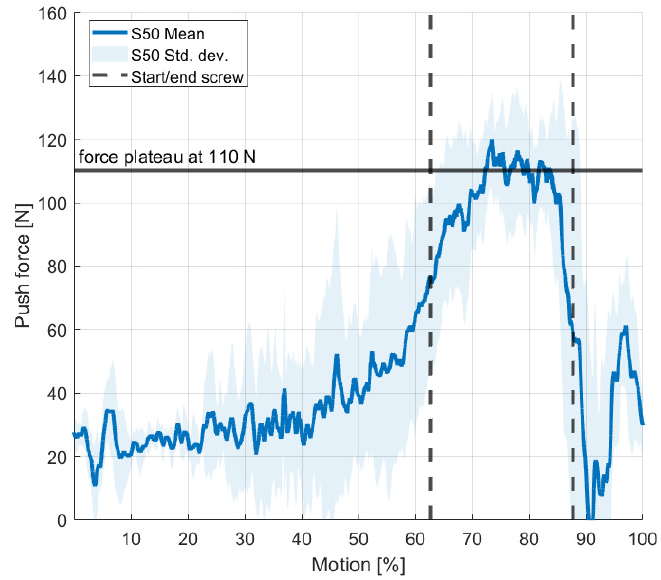
Figure 5. Exemplary course of the mean push force for participant P3, task T1, and support condition S50 with the start- and endpoint of the screw phase. A push force plateau could be recognized during the screw phase.